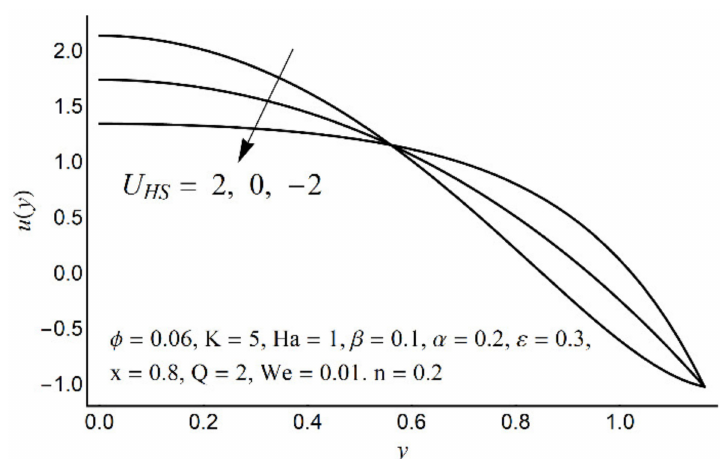
Figure 3. Axial velocity u ( y ) for various U HS